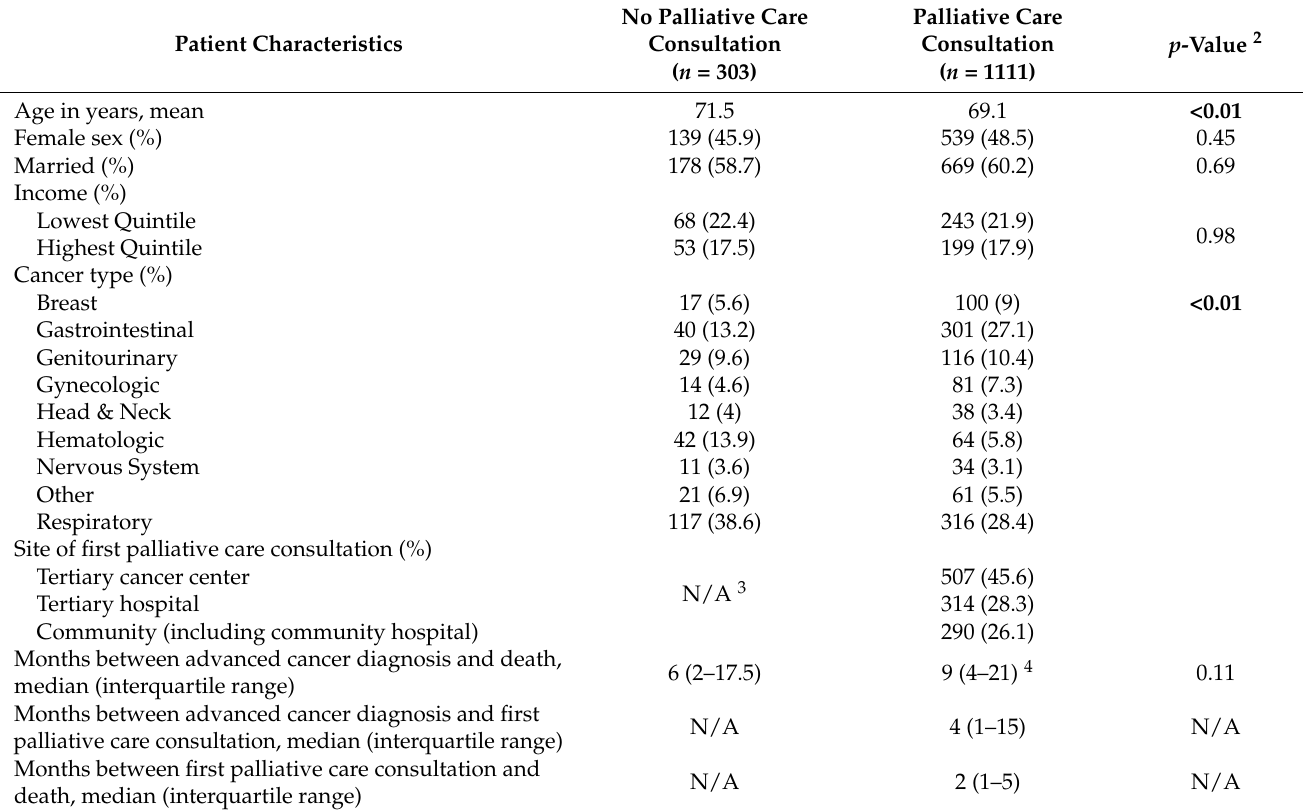
Table 1. Patient characteristics based on any EZPCP 1 consultation ( N =